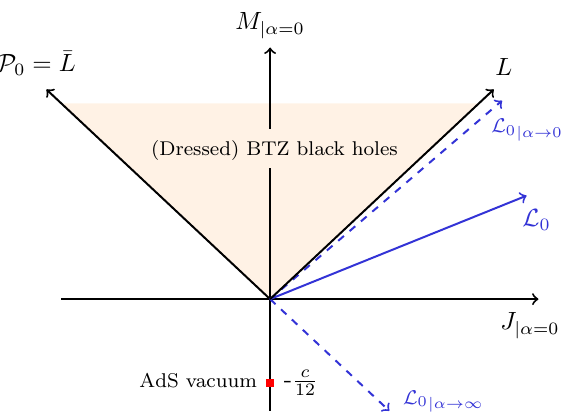
Figure 1. Spectrum of 3D gravity with CSS boundary conditions where zero modes of the Virasoro-Kac-Moody algebra. As (cid:11) we recover the Brown-Henneaux identi(cid:12)cation of mass and angular momentum. while descendants of primary states with note that the (cid:22) L -dependent (second) term in eq. (2.5) is almost the Sugawara contribution of the U(1) algebra, except that it is missing the appropriate powers of